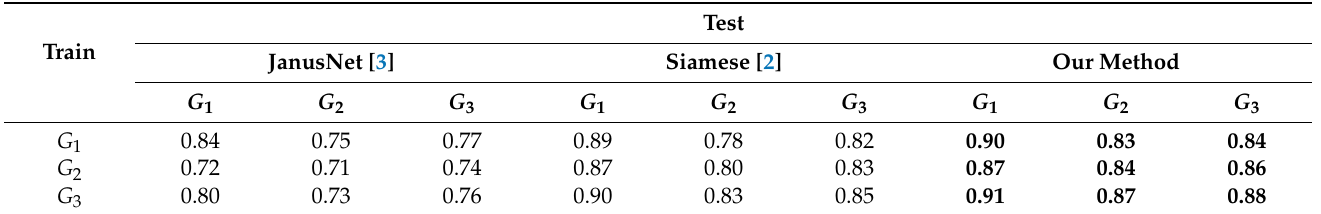
Table 8. Comparison of results achieved by different methods on the dataset splits according to head and shoulder movements and partial